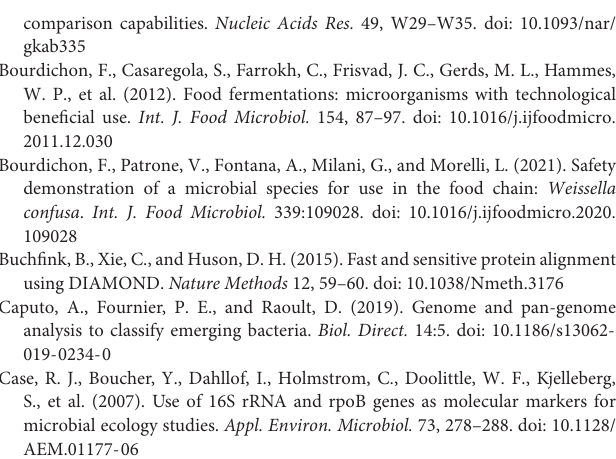
Supplementary Figure 1 | Distribution of core, accessory, and unique genes on COG category. Supplementary Figure 2 | Phylogenetic tree of the intact phages identified in W. confusa